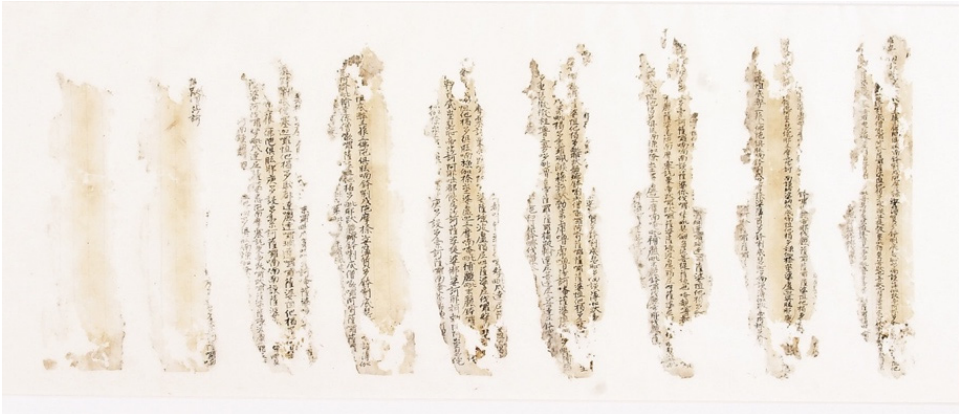
Figure 7. Pagoda-stamped sheets, Unified Silla, eighth-to-ninth centuries, H. 24.5 cm, Hwa˘omsa Buddhist Museum [©CBM].